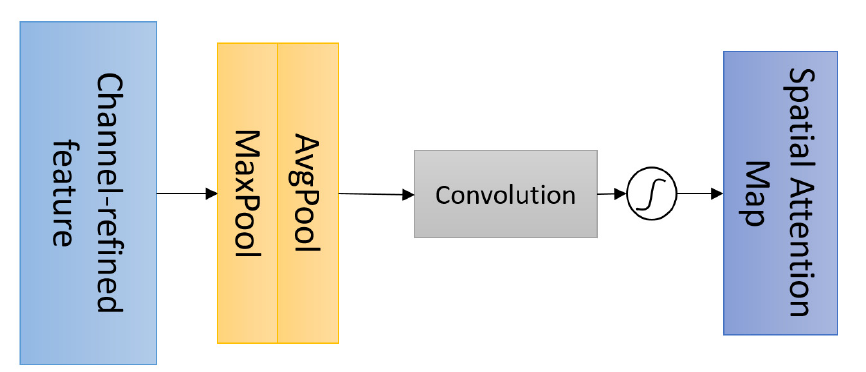
Figure 6. Spatial attention module.